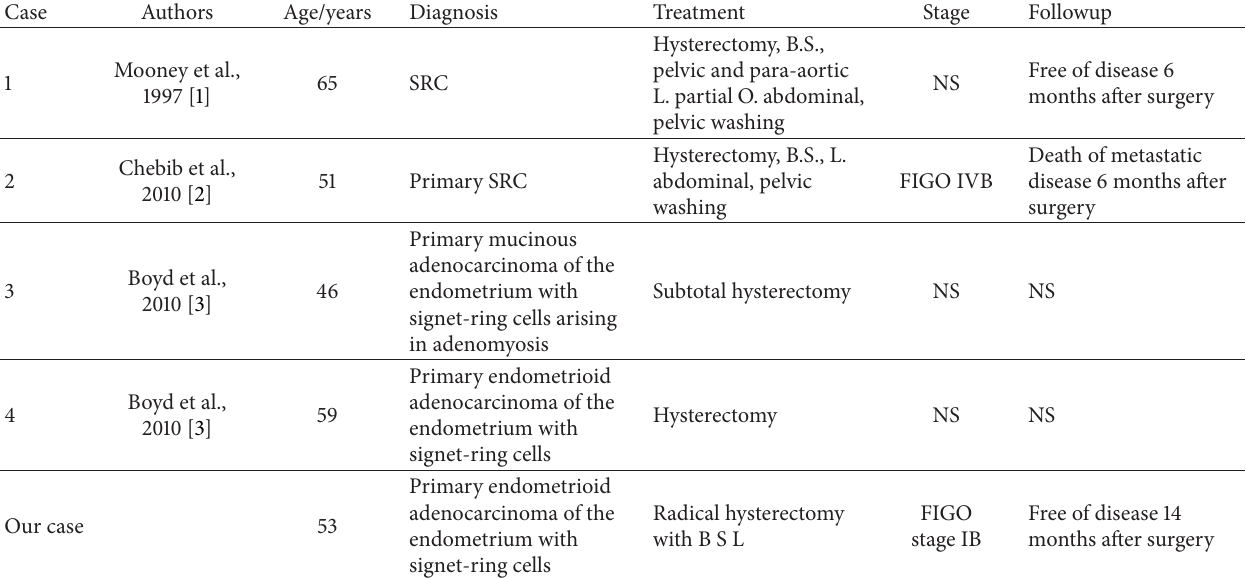
Table 1: Endometrial adenocarcinoma with signet-ring cells: review of the literature.